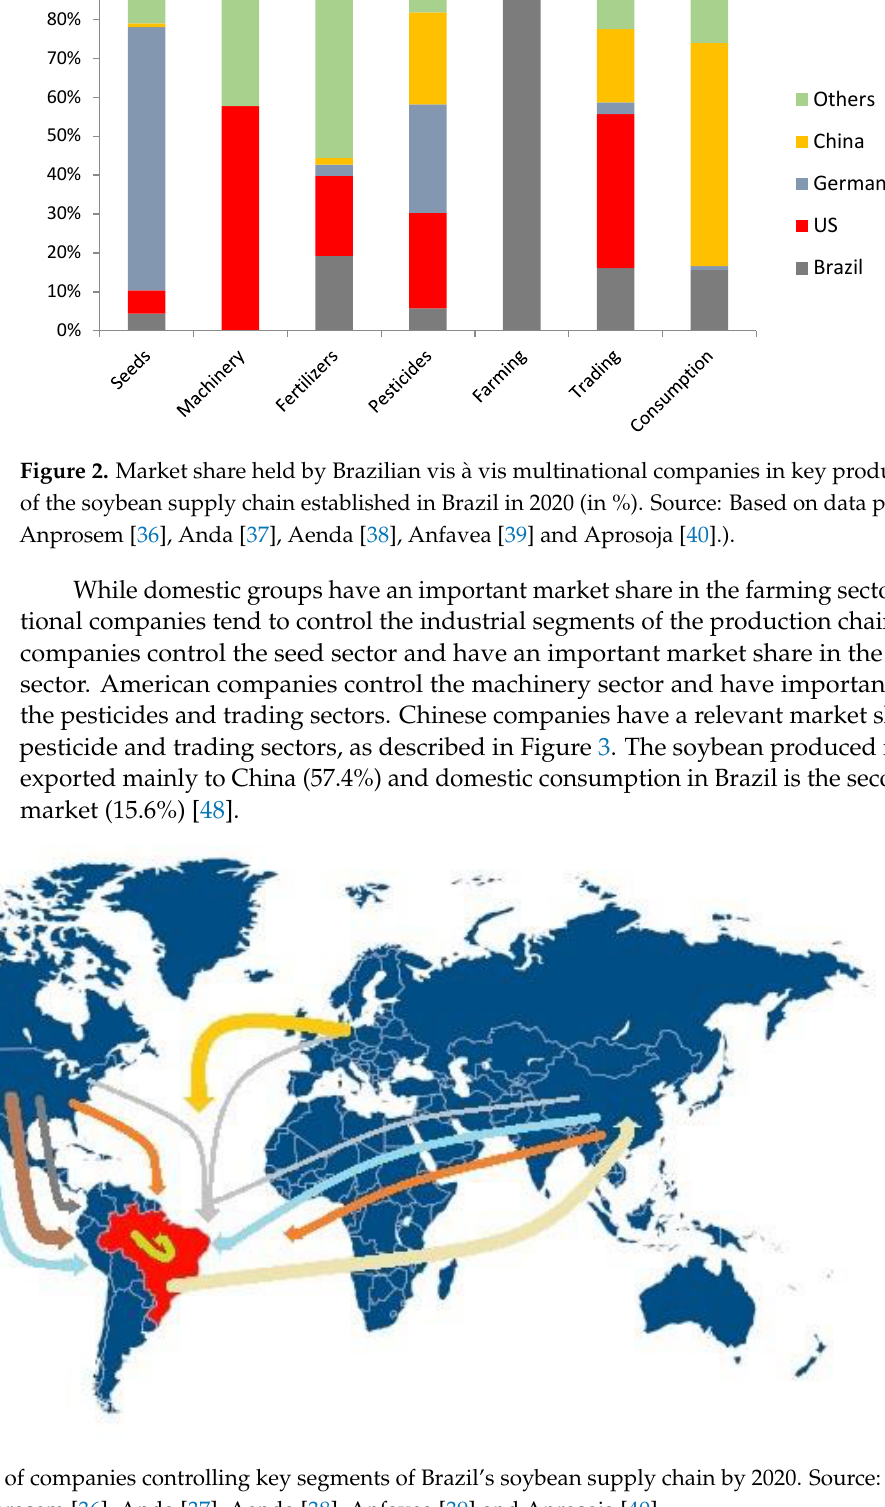
Figure 3. Home countries of companies controlling key segments of Brazil’s soybean supply chain by 2020. Source: Based on data published by Anprosem [36], Anda [37], Aenda [38], Anfavea [39] and Aprosoja